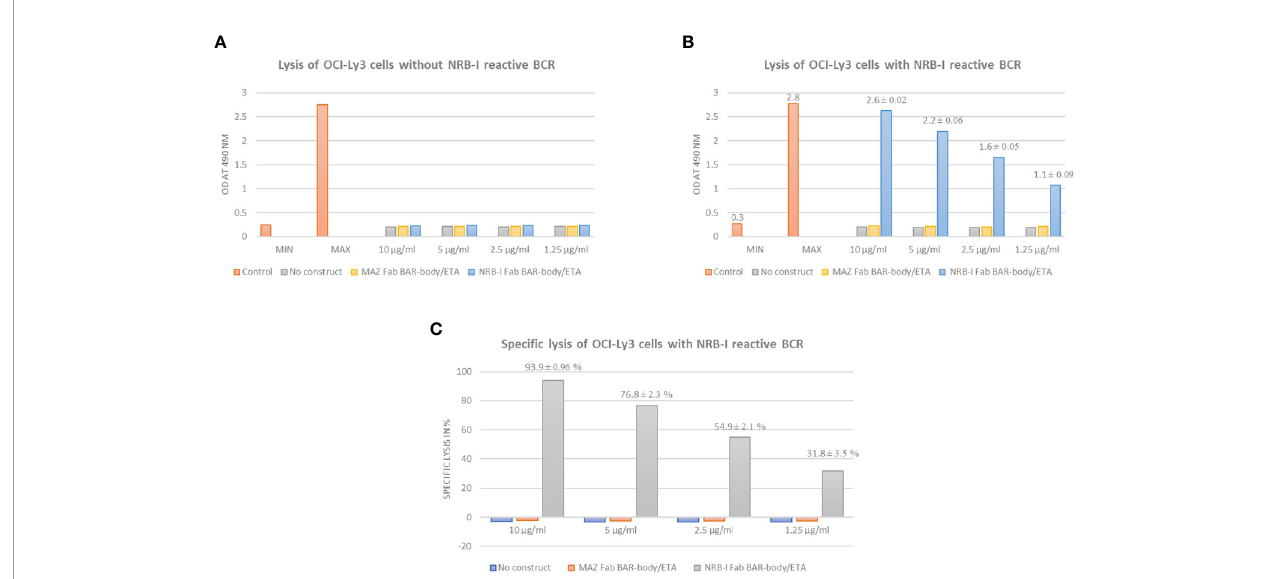
FIGURE 3 | Heavy-chain-only Fab-format neurabin-I BAR-body induced speci fi c cytotoxicity as measured by LDH release. MAZ/ETA, an irrelevant antigen (BCR target of the leukemic cells of a CLL patient) linked to pseudomonas exotoxin A, was used as control. All experiments were performed in triplicate. (A) Heavy-chain- only Fab-format neurabin-I BAR-body incubation with OCI-ly3 DLBCL cells at different concentrations (1.25 – 10 µg/ml) results in no LDH release indicating no unspeci fi c Fab-format BAR-body induced cytotoxicity. (B) Heavy-chain-only Fab-format neurabin-I BAR-body at different concentrations (1.25 – 10 µg/ml) confers cytotoxicity to OCI-ly3 DLBCL cells transfected with neurabin-I reactive BCRs. Maximum LDH release is reached at approximately 10 µg/ml. (C) Fab-format neurabin-I BAR-bodies mediate speci fi c lysis (calculated as described in the material and methods section) in a dose dependent manner, starting with approximately 30% at 1.25 µg/ml and reaching >90% at 10